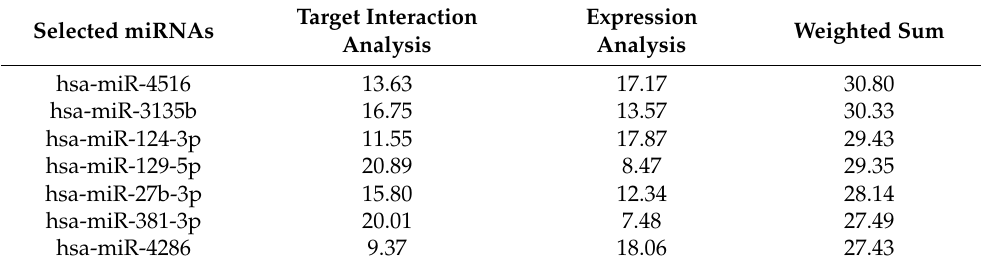
Table 3. Final miRNA selection. MiRNAs were selected by an in silico algorithm. The table contains separated values of target gene analysis and expression analysis, as well as combined